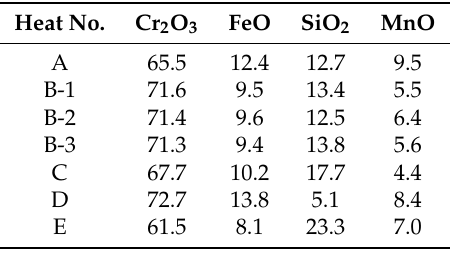
Table 4. Normalized chemical composition for slags from five heats, where CaO and MgO have been excluded (mass%).